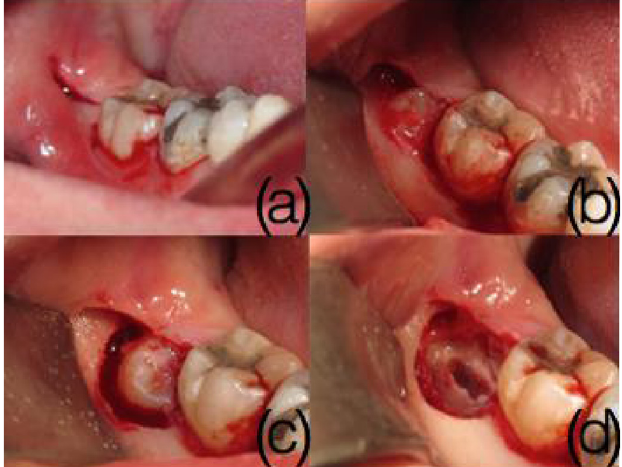
Fig. 2. (a) Incision, (b) Full-thickness fl ap elevation, (c) alveolect- omy to the cemento-enamel junction, (d) crown separation and enamel reducing to 2 – 4mm below the level of alveolar crest.